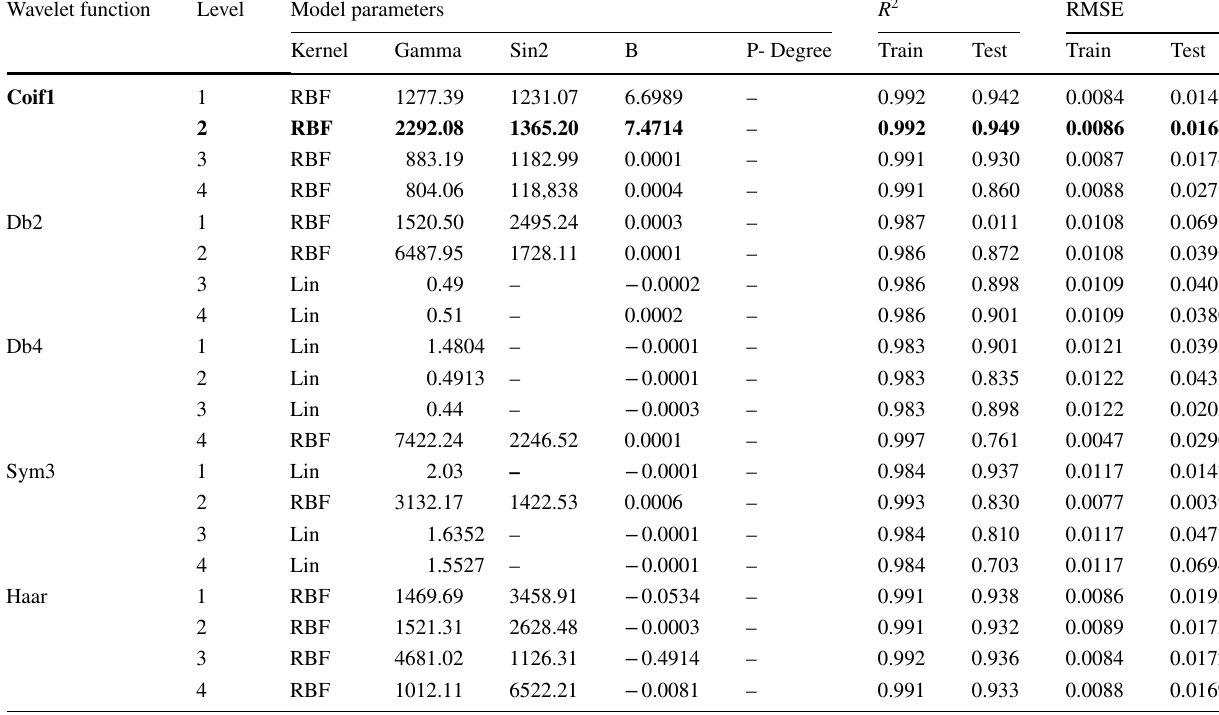
Table 7 Result of W-SVR model at the monthly scale with different mother wavelets and decomposition levels